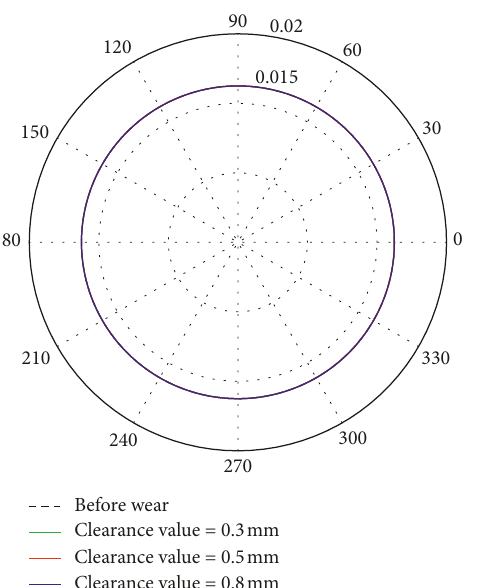
Figure 34: Local enlarged drawing of bearing surface of joint B